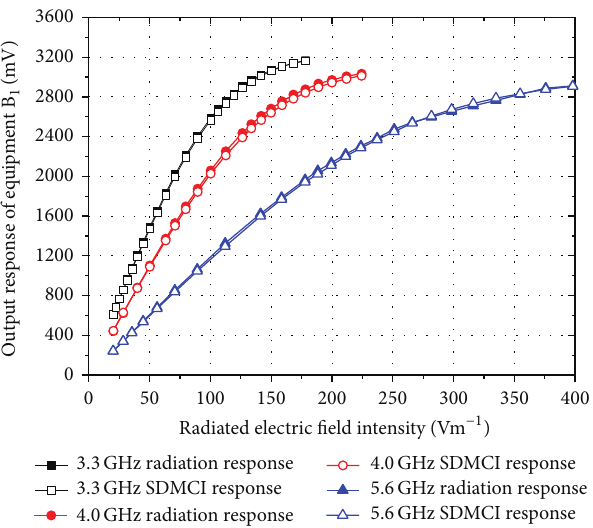
Figure 15: The response curves under the condition of radiation and SDMCI test.